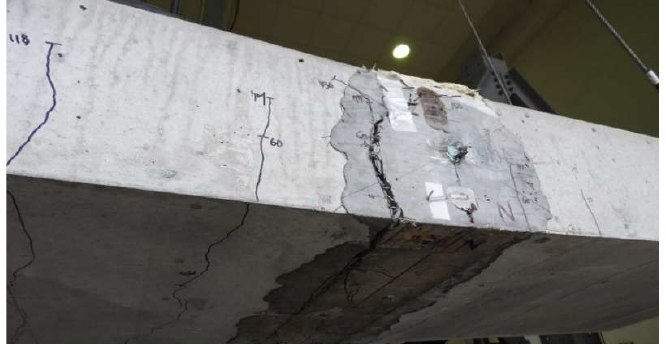
Figure 9. Type B specimen at end of bending test (North side).